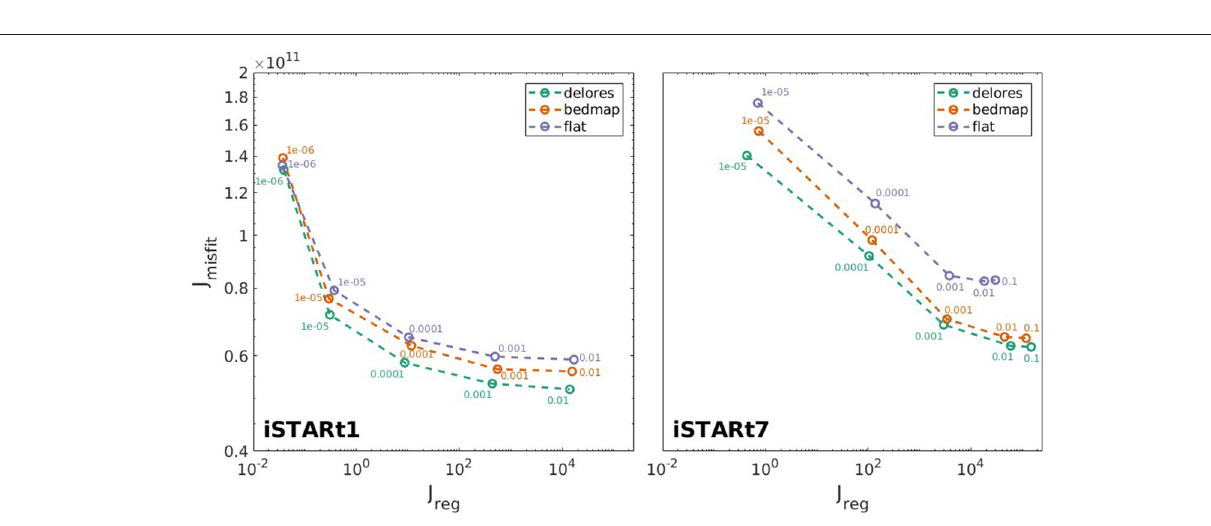
FIGURE 6 | L-curve for results of the model over iSTARt1 and iSTARt7. The value of the regularization term, J reg 1 , from Equation (11), is plotted against the value of the misfit term, J mis . Values are plotted forresults of the model with a range of values of the coefficient, γ , which governs the relative contribution of regularization and misfit in the cost function. Every point is labeled with the value of γ and the color corresponds to what bed elevation dataset has been used. It is clear that misfit is reduced further by using more fully resolved bed elevation measurements i.e., DELORES measurements rather than BEDMAP2 or a completely smoothed